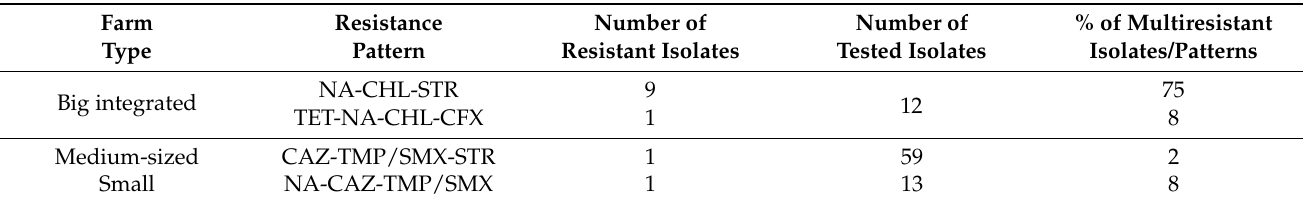
Table 6. Prevalence and resistance patterns of multiresistant Y. enterocolitica 4/O:3 in pig tonsils from different farm types